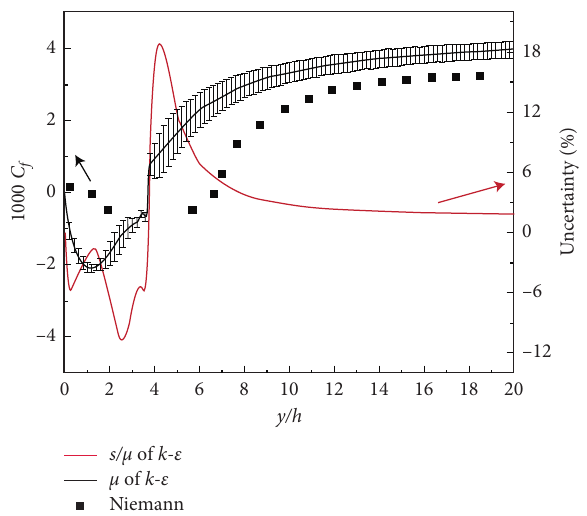
Figure 13: Friction coefficient along the bottom wall with 6s uncertainty.